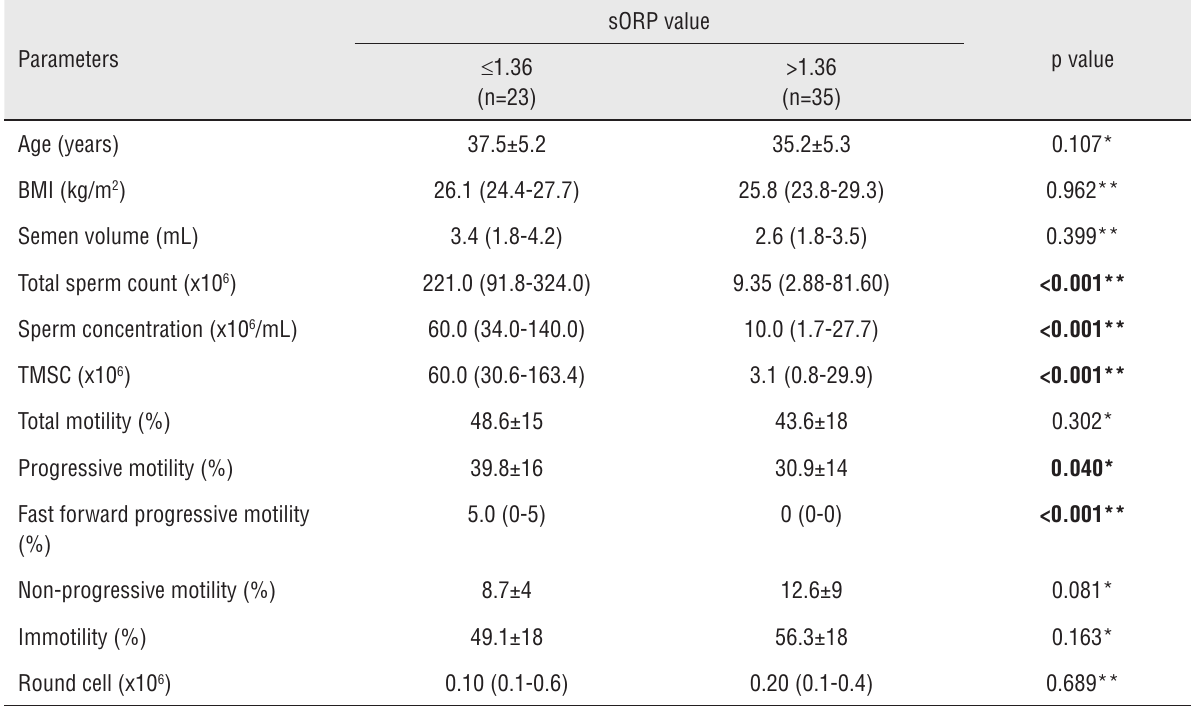
Table 1. Baseline characteristics and comparison of sperm parameters between infertile men with normal and high sORP